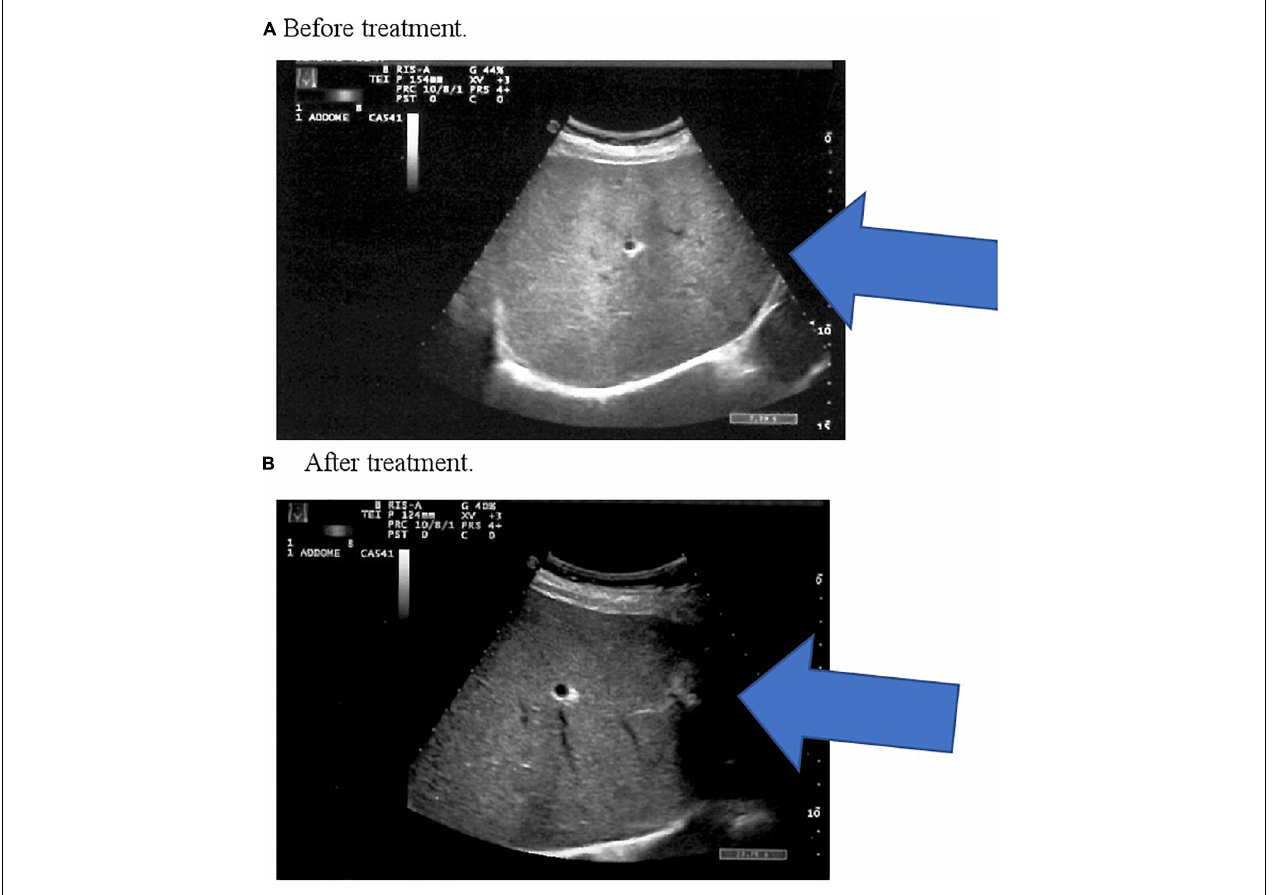
FIGURE 1 | (A) Before treatment. (B) After treatment. In panel (A) there is an increased echogenicity of the liver, a classic sonographic finding of hepatic steatosis. In panel (B) ultrasound image shows normal echogenicity of the liver